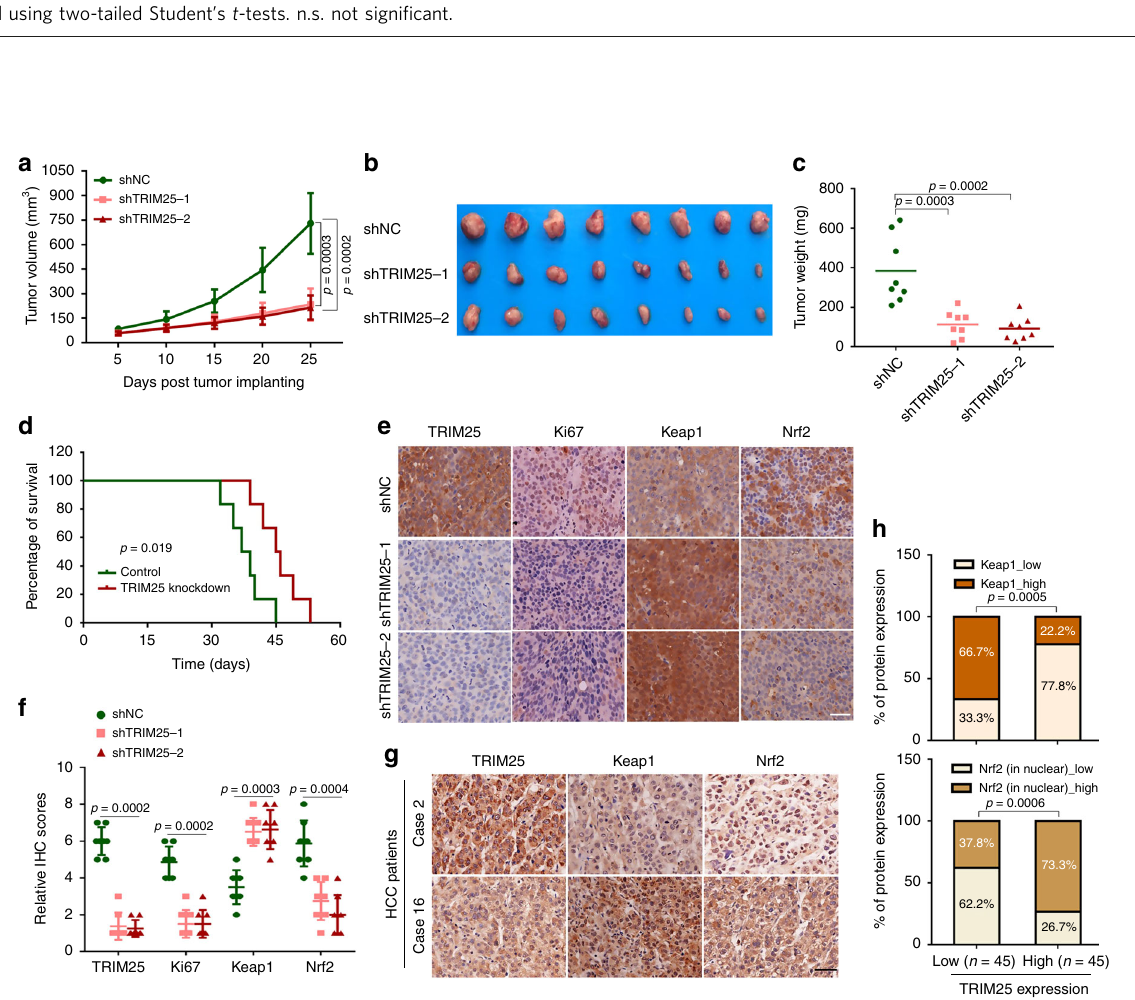
Fig. 5 TRIM25 negatively regulates tumor cells ’ ROS and apoptosis in cooperation with Nrf2. a Western blot analysis of the levels of cleaved caspase3 in HCT116 and Huh7 cells for control (shNC) or after stable knockdown of TRIM25. b , e Western blot analysis of the levels of cleaved caspase3 in Huh7 cells for stalely knockdown ( b ) or overexpression ( e ) of TRIM25 treated with TM (5 μ g/ml) or TG (1 μ M) for 12 h. c, g Quanti fi cation of apoptotic HCT116 cells stable knockdown ( c ) or overexpression ( g ) of TRIM25, treated with or without TG (1 μ M) for 12 hand analyzed by fl ow cytometry. f Western blot analysis of the levels of cleaved caspase3 in control and F-TRIM25-expressing HCT116 cells, treated with or without TG (1 μ M) for 12 h. d , h Quanti fi cation of apoptotic Huh7 cells stable knockdown ( d ) or overexpression ( h ) of TRIM25, treated with TM (5 μ g/ml) or TG (1 μ M) for 12 h and analyzed by fl ow cytometry. i Western blot analysis of the ef fi ciency of the stable cell knocks down of Nrf2 in HCT116 and Huh7 cells. j Quanti fi cation of ROS level and apoptotic HCT116 cells expressing control or F-TRIM25 and with simultaneously knockdown of Nrf2, treated with or without TG (1 μ M) for 12 h. k , m Quanti fi cation of ROS level ( k ) and apoptotic ( m ) Huh7 cells expressing control or F-TRIM25 and with simultaneously knockdown of Nrf2, treated with TM (5 μ g/ml) or TG (1 μ M) for 12 h. l Western blot analysis of the levels of cleaved caspase3 in control and F-TRIM25-expressing HCT116 cells after stable knockdown of Nrf2, treated with or without TG (1 μ M) for 12 h. For c , d , g , h , j , k , and m , data represent the mean ± SEM ( n = 3). Statistical signi fi cance was assessed using two-tailed Student ’ s t -tests. n.s. not signi fi cant.